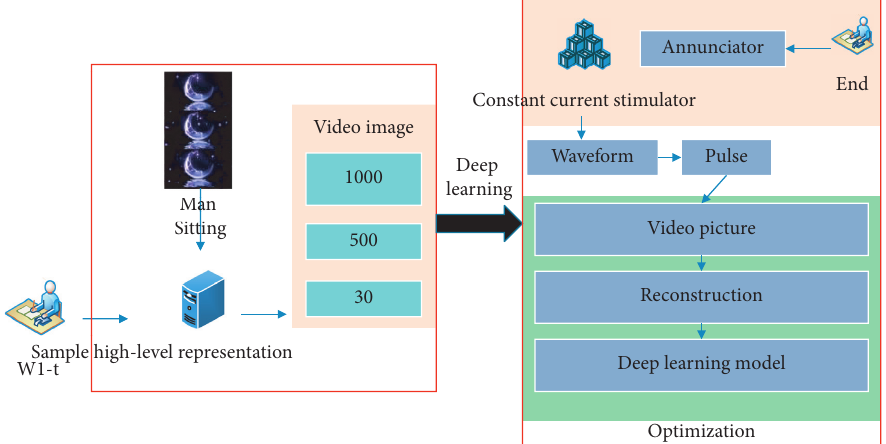
Figure 5: Data collection and statistics module